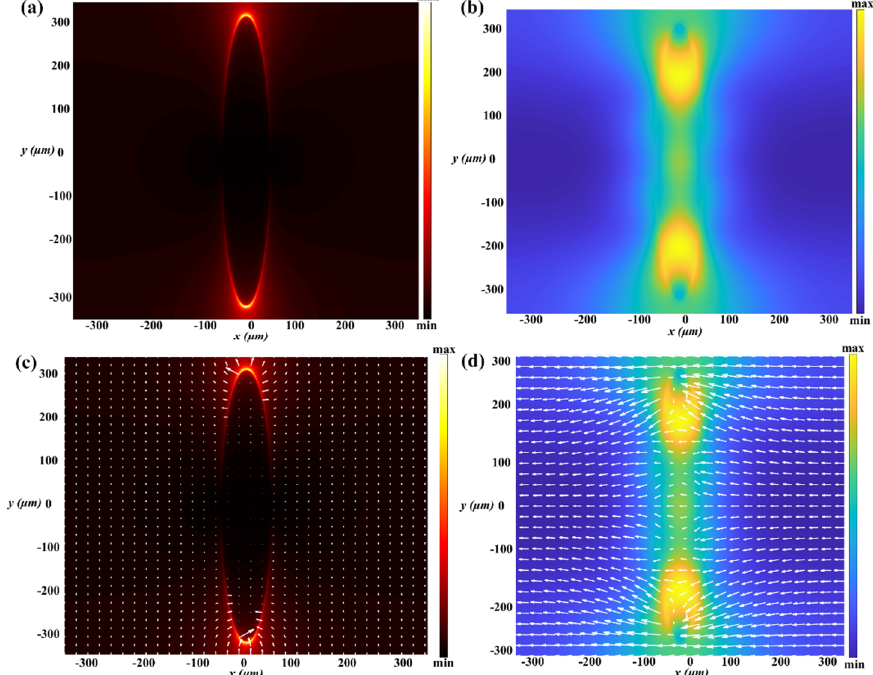
Figure 11. The distribution of the electromagnetic field and its vector in the x-y plane of the surface of the STO particle: ( a , b ) the electric and magnetic field, respectively. ( c , d ) The electric field and magnetic field vector, respectively. All frequencies are set at 0.119 THz and the incident light is set as y -polarized.